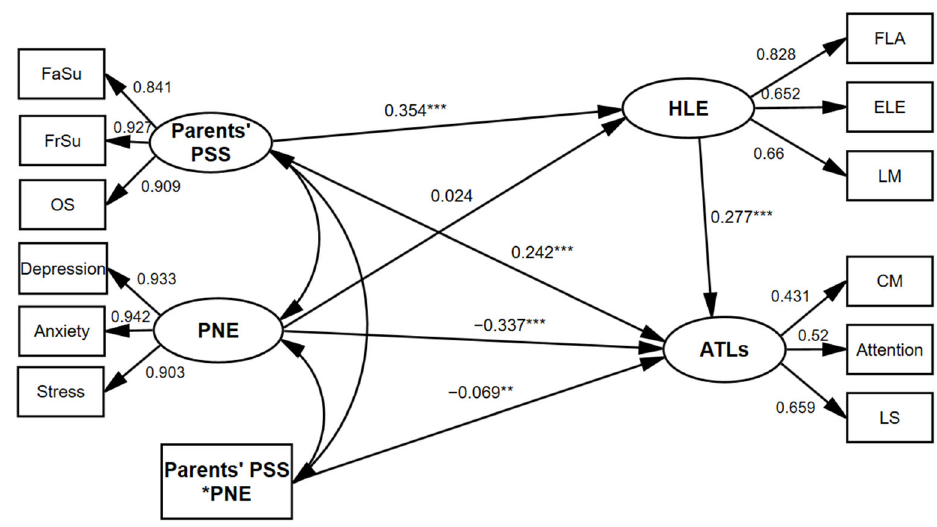
Figure 2. A moderated mediation model. * p < 0.05, ** p < 0.01, *** p < 0.001; Parents’ PSS = Parents’ perceived social support, OS = Other support, PNE = Parental negative emotion, HLE = Home learning environment, FLA = Family learning activities, ELE = Enriching life experience, LM = Learning materials, ATLs = children’s approaches to learning, CM = Competence motivation, LS = Learning strategy.